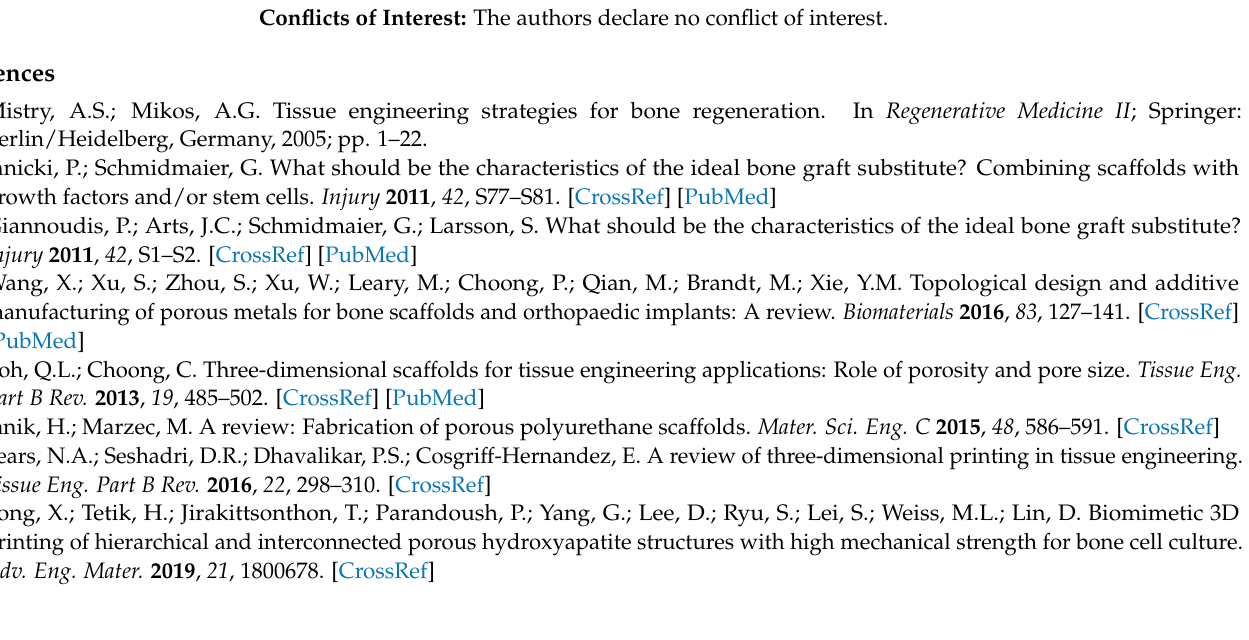
treatments, Figure S2: Strut and pore dimensions obtained for the different scaffolds, Figure S3: TGA curves of PCL and PCL/HA scaffolds, Figure S4: Stress-strain curves of PCL and PCL/HA scaffolds with different surface treatments. ( × : Rupture Point, Black: untreated, Red: O 2 plasma-treated,